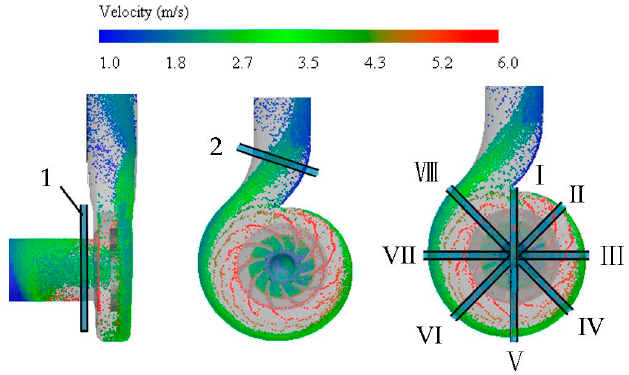
Figure 4. Section diagram. Figure 4. Section